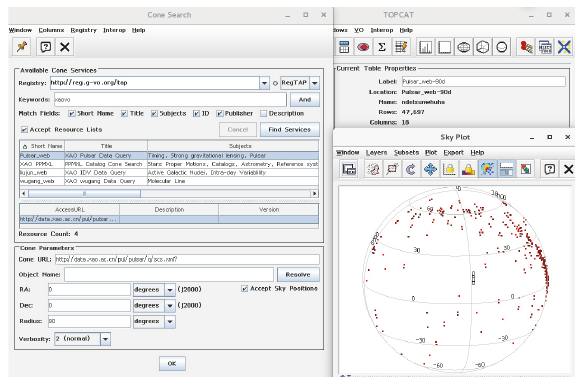
Figure 6: VO tool retrieval results.